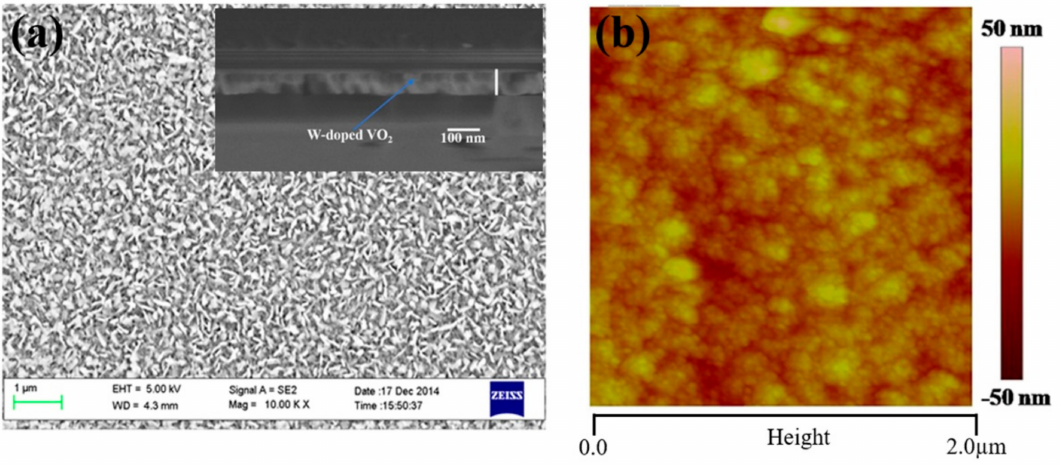
Figure 4. SEM and AFM images of the W-doped VO 2